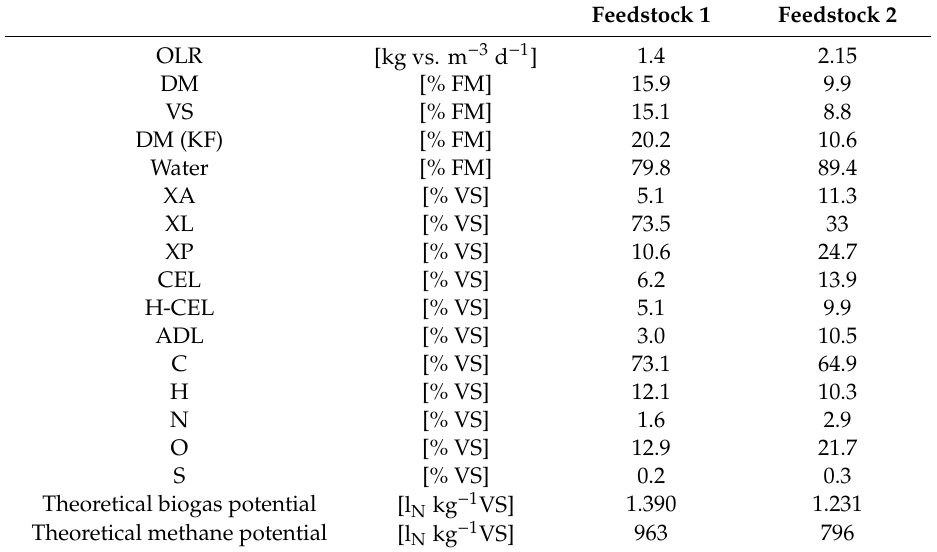
Table 1. Composition of feedstocks 1 and 2, including dry matter (DM), water content, volatile solids (VS), elemental composition, C / N ratio, theoretical biogas and methane